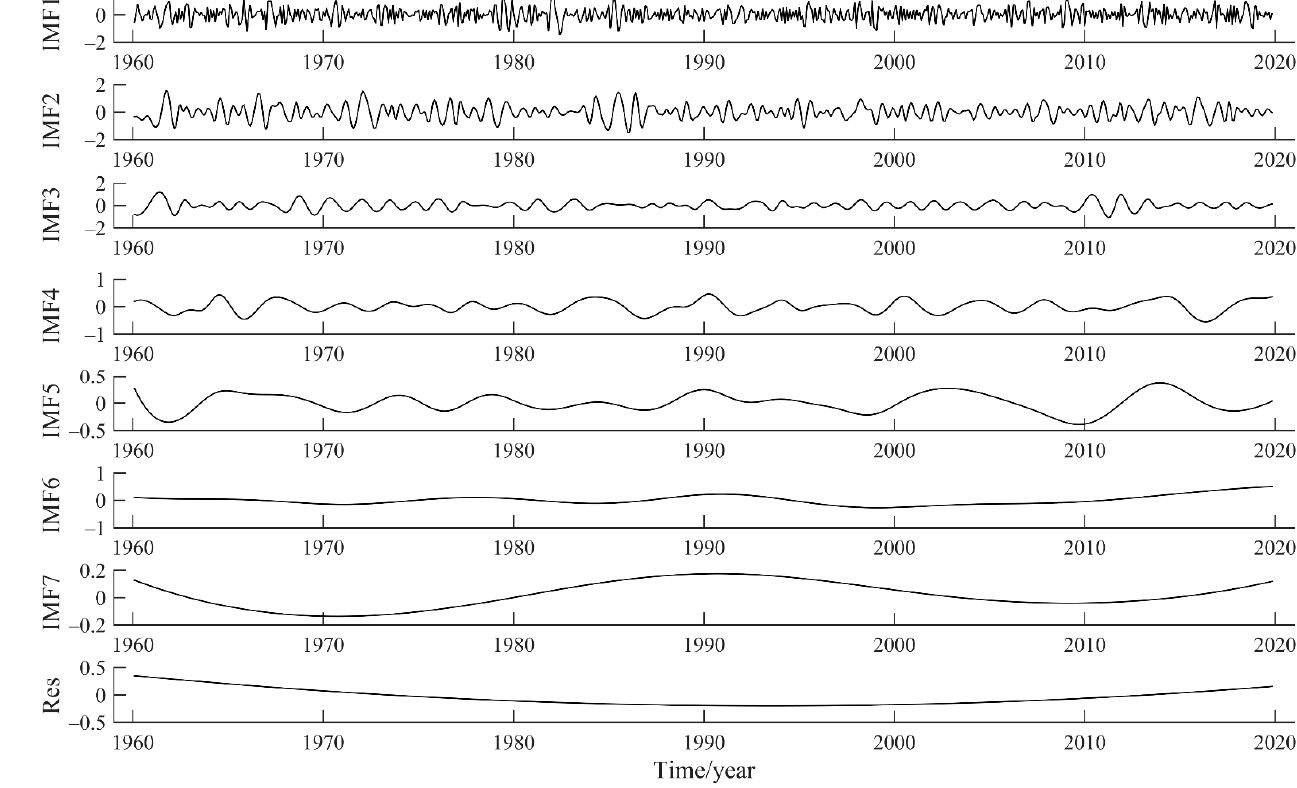
Figure 4. The CEEMD decomposition results of the SPI3 sequence at Xiji Station. A stationary test was carried out for the components decomposed by CEEMD. IMF1~IMF6 were stationary time series; therefore, the ARMA model was selected for